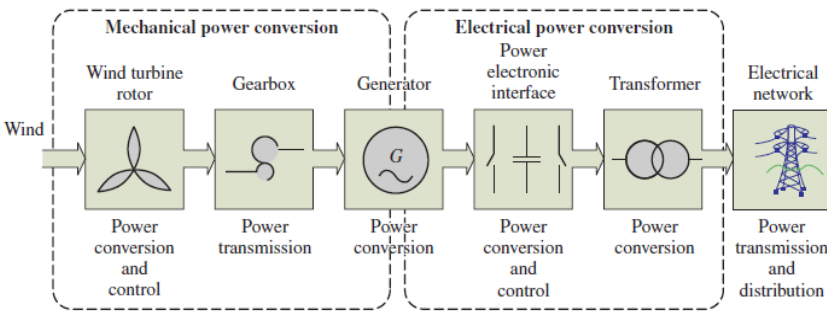
Figure 1. Converting wind power into electrical power with a wind